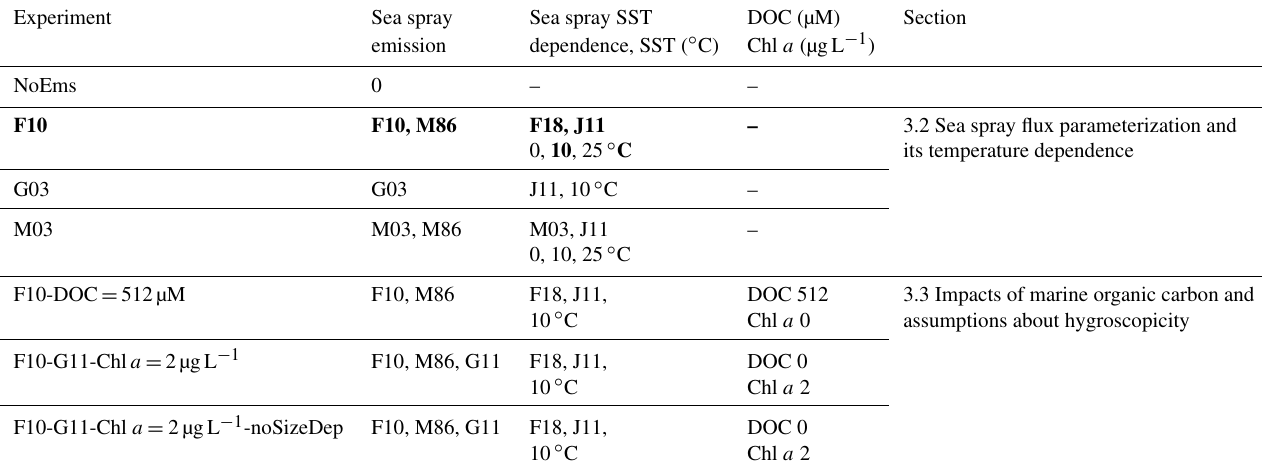
Table 1. Model experiments for sea spray emission.